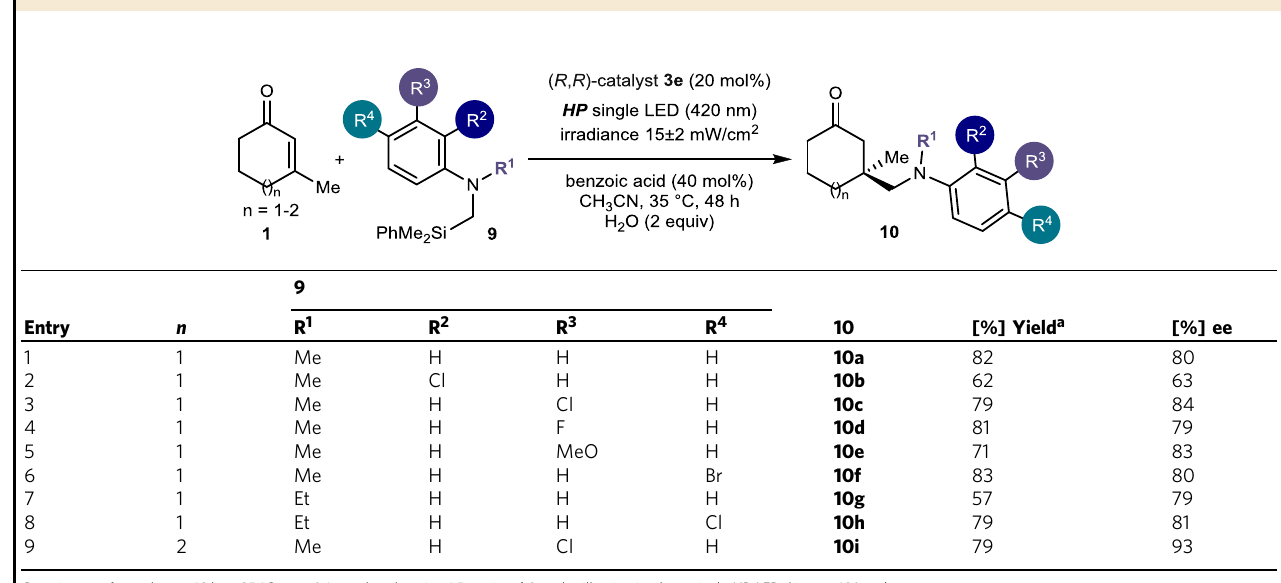
Table 3 Substrate scope for the enantioselective trap of α -silyl amine-derived